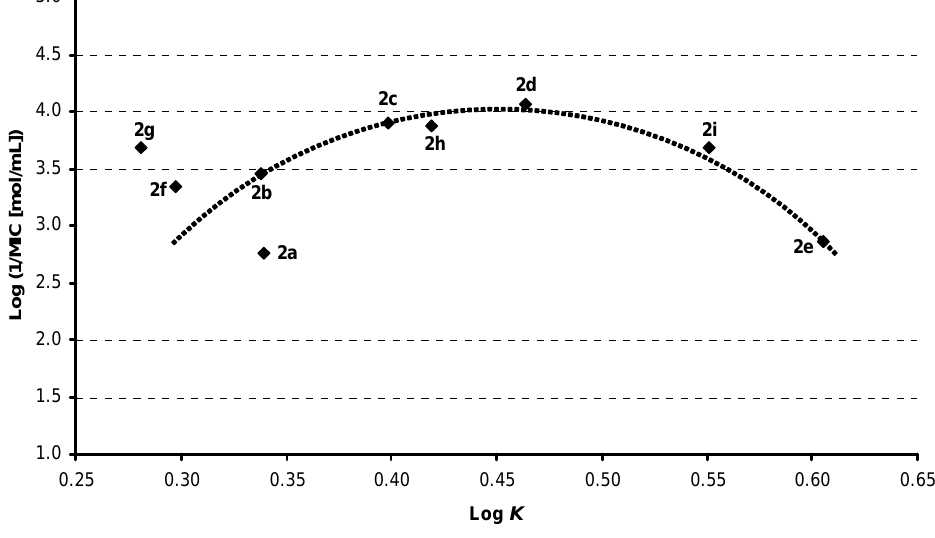
Figure 1. Dependence between the sum of in vitro antifungal activity against all the eight tested fungal strains {log (1/MIC [mol/mL])} and logarithm of the retention factor (log K ) of the studied compounds 2a - i